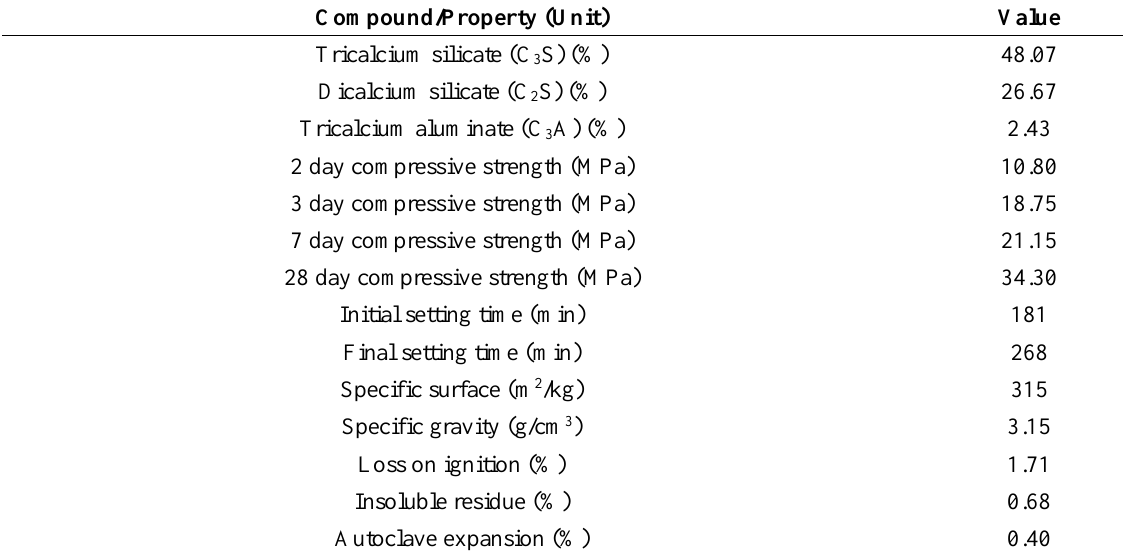
Table 2. Mechanical and physical properties of Portland cement